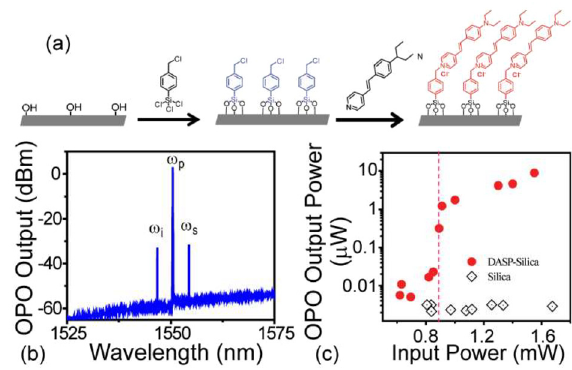
Figure 8: DASP coated silica resonant cavity for four wavemixing. (a) Overview of surface chemistry method used to create an aligned monolayer of DASP molecules on the device surface. (b) Representative optical parametric oscillation (OPO) spectrum. (c) Threshold power comparing non-functionalized and DASP-functionalized devices. Reproduced from reference [232].